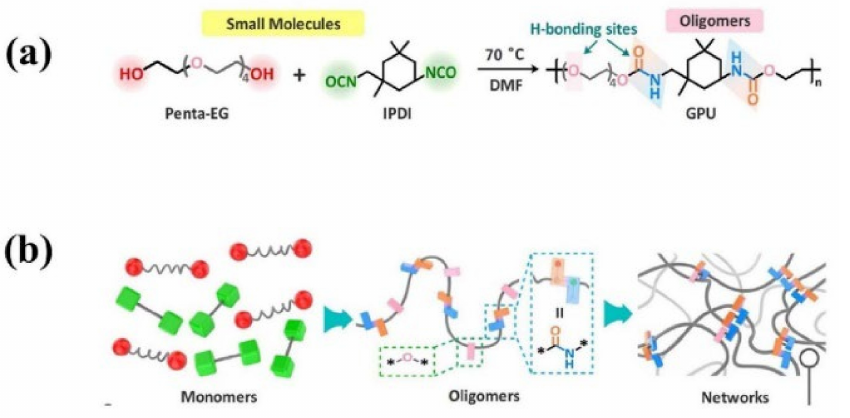
Figure 6. ( a ) Molecular structure, synthetic process, and illustration of GPU polymer and ( b ) cross- linked network inside of it. Reproduced with permission from [98]. Copyright 2021 Wiley- VCH